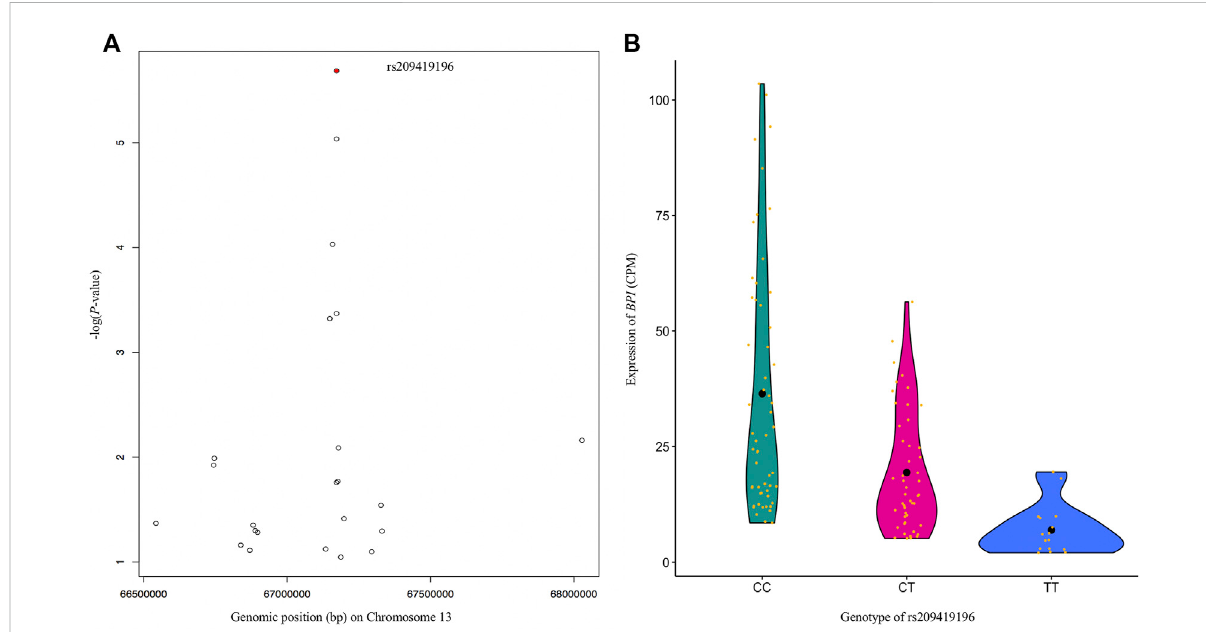
FIGURE 4 Regional Manhattan plot (A) for all SNPs around 1 Mbp up- and down-stream of BPI . SNP rs209419196 (red dot) is the most signi fi cant SNP associated with expression of BPI . Violin plot (B) of the effects of three genotypes (CC, CT, and TT) of rs209419196 on the expression of BPI . The differences in BPI expression among CC, CT, and TT were signi fi cant ( p -value <